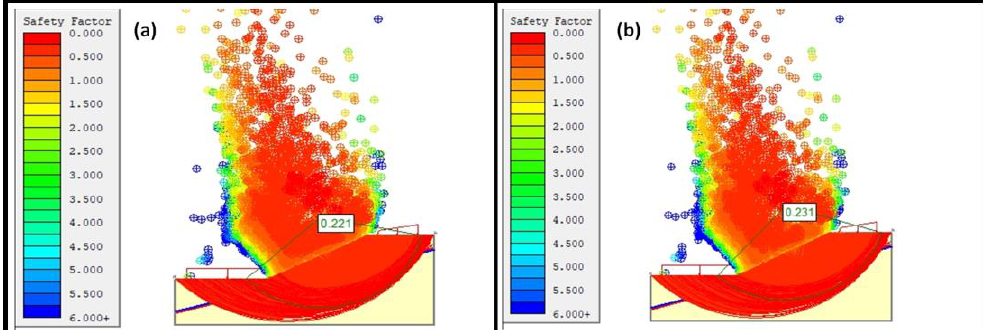
Figure 12. Safety factor simulated for rainy conditions in clay soil slope using ( a ) Spencer’s method and ( b ) Corp of Engineers’ Number One . The two methods also agree with the previous two techniques (see Figure 11a,b) used to simulate the FoS.